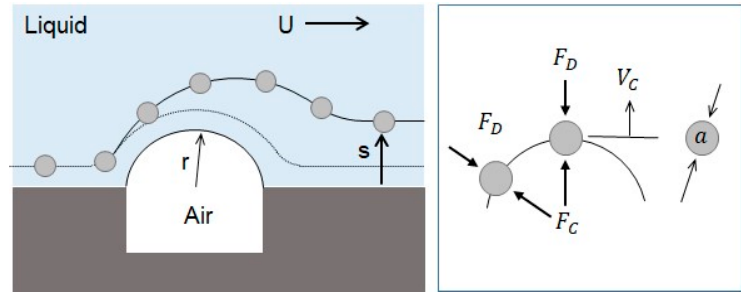
Figure 10. Drift of microspheres away from wall caused by centrifugal force.